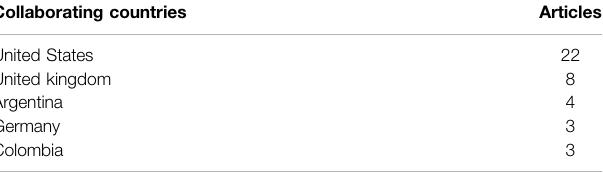
TABLE 4| Maincountriescontributingtotheresearchofthecorpus(1993 – 2019). Collaborating